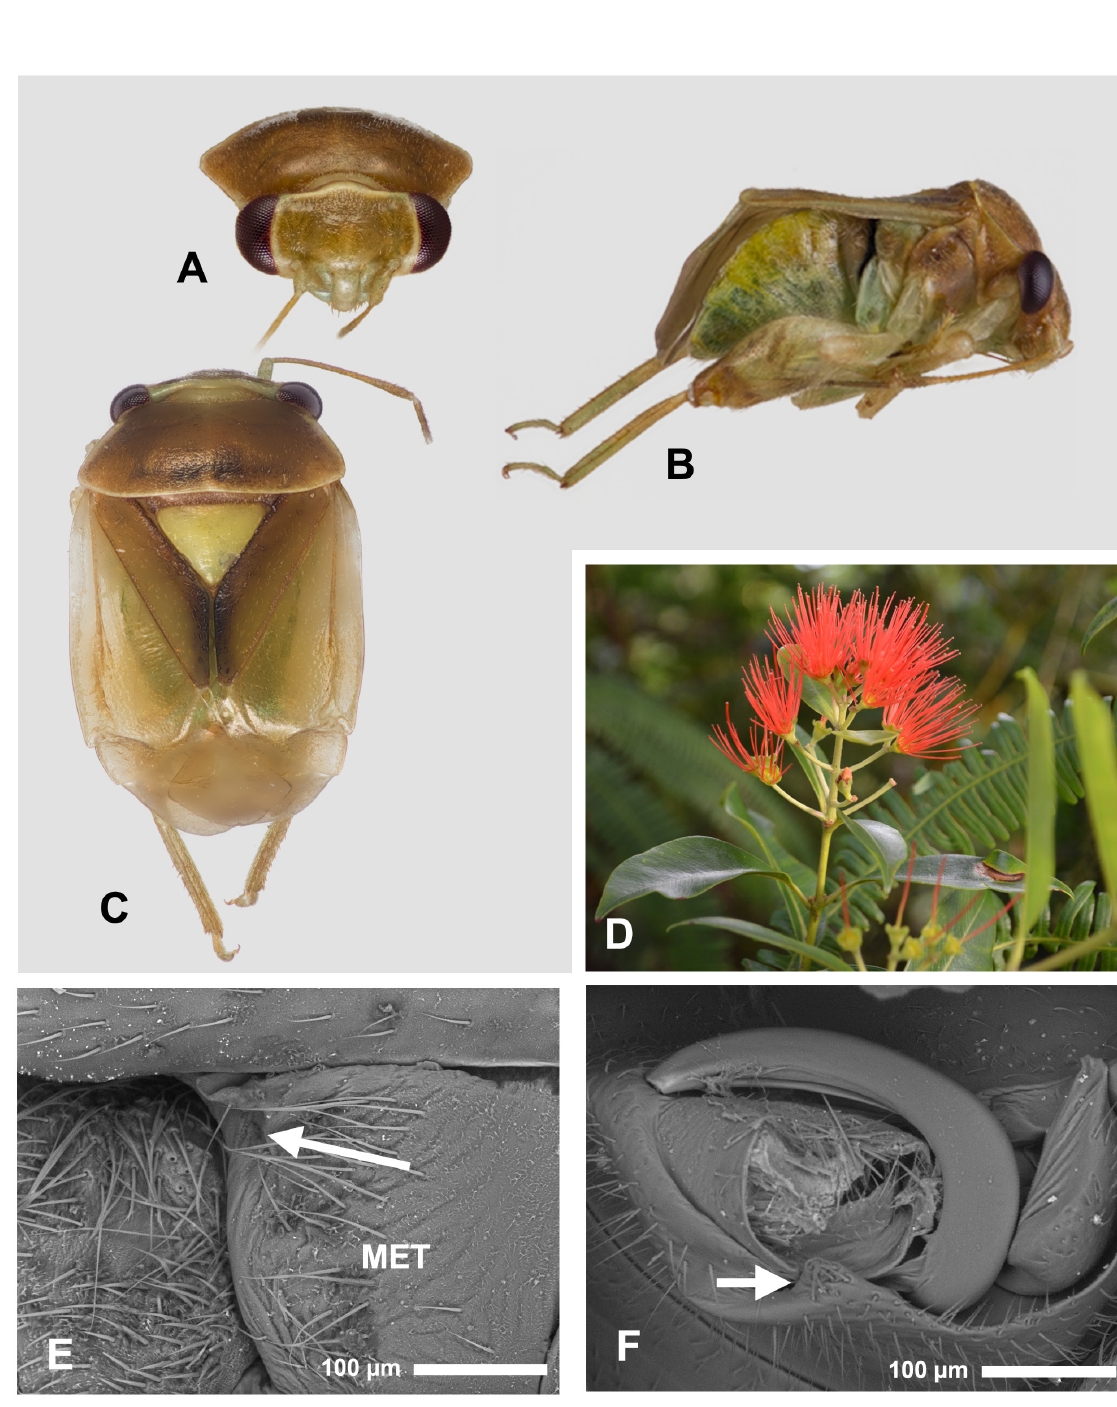
Fig. 7. Photographs and scanning electron micrographs of Coridromius taravao sp. nov. and Metrosideros collina . A . Head and pronotum, anterior view. B . Right lateral view, ♀. C . Dorsal habitus, ♀. D . Photograph of Metrosideros collina at Taravao Plateau. E . Detail of metepimeral lobe and anterior of abdomen; arrow indicates possible site of insemination. F . ♂ genitalia, apex of left paramere broken off; arrow indicates apophysis of pygophore margin. MET = metapimeral